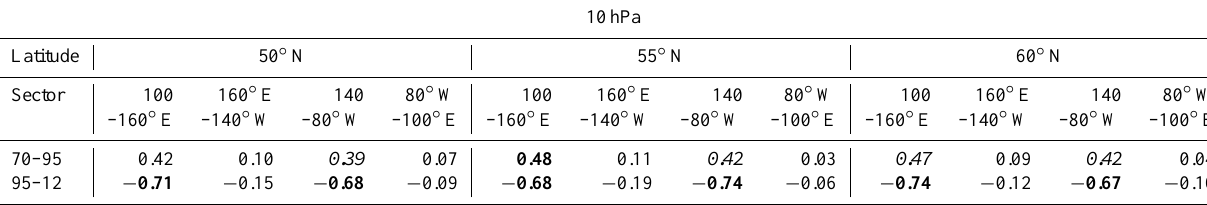
Table 2. Winter (December–February) trends (ms − 1 per year) of the meridional wind speed for two periods (1970–1995 and 1996–2012). Major SSW: only years when the major SSWs (according to WMO definition) occur; no SSW: years when no major SSW occurs; east QBO: only years under the east phase of QBO; west QBO: only years under the west phase of QBO. Pressure level 10hPa. 70–95 means 1970–1995 and 95–12 means 1995–2012. Trends significant at the 99% level are highlighted in bold; trends significant at the 95% level are in italics.